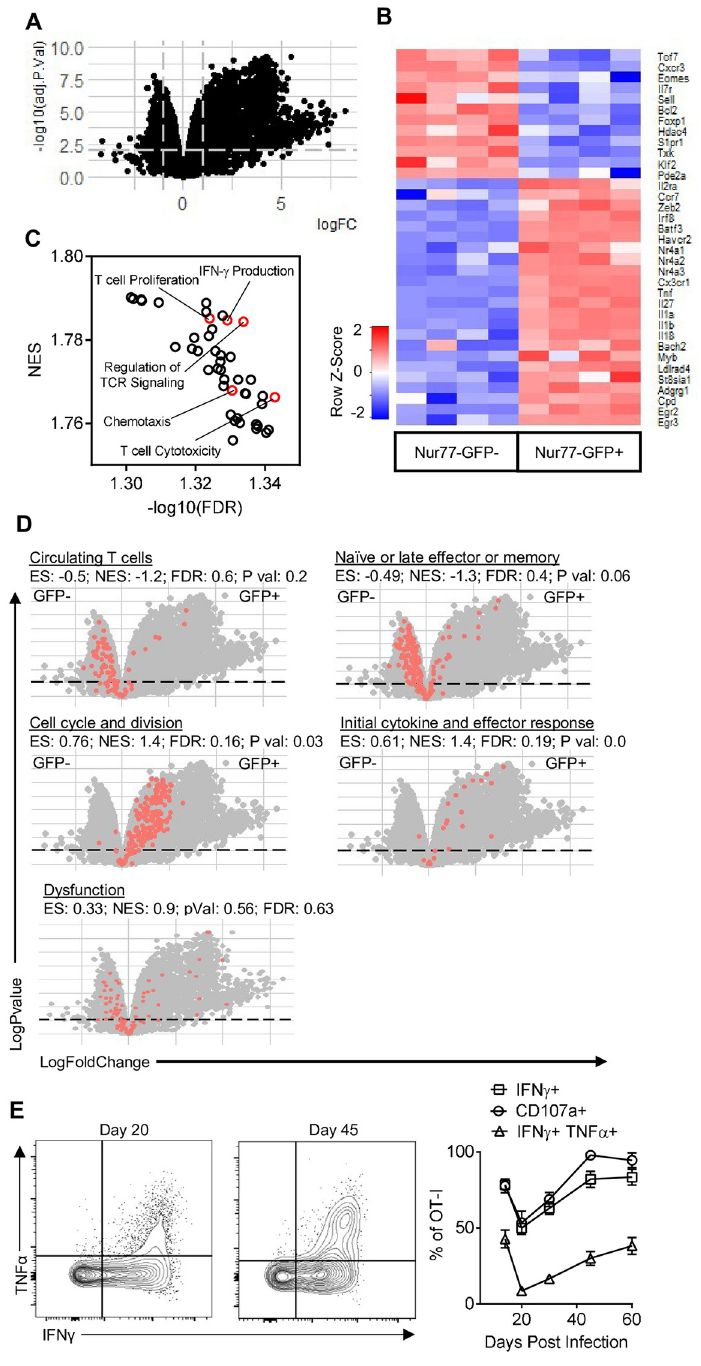
Fig 5. Transcriptional profiling of Nur77-GFP OT-I from CNS. (A-D) Nur77-GFP - and Nur77-GFP + OT-I from the brains of mice infected with T . gondii -OVA 14 dpi were transcriptionally profiled using RNA-sequencing (N = 4 pools of 2 mice per pool). (A) Volcano plot of all transcripts. Lines indicate logFC > 0.03 and adjusted P-value > 0.05. (B) Heatmap of differentially expressed genes involved in CD8+ T cell activation, differentiation, memory formation, and effector function. (C) Top GSEA enriched pathways in Nur77-GFP + OT-I compared to Nur77-GFP - OT-I. (D) Gene sets involved in CD8+ T cell activation and differentiation (red dots). (E) OT-I from brains of T . gondii -OVA infected mice were restimulated with SIINFEKL peptide and cytokine and degranulation was assessed by flow cytometry (N = 3–5 mice per group per timepoint).